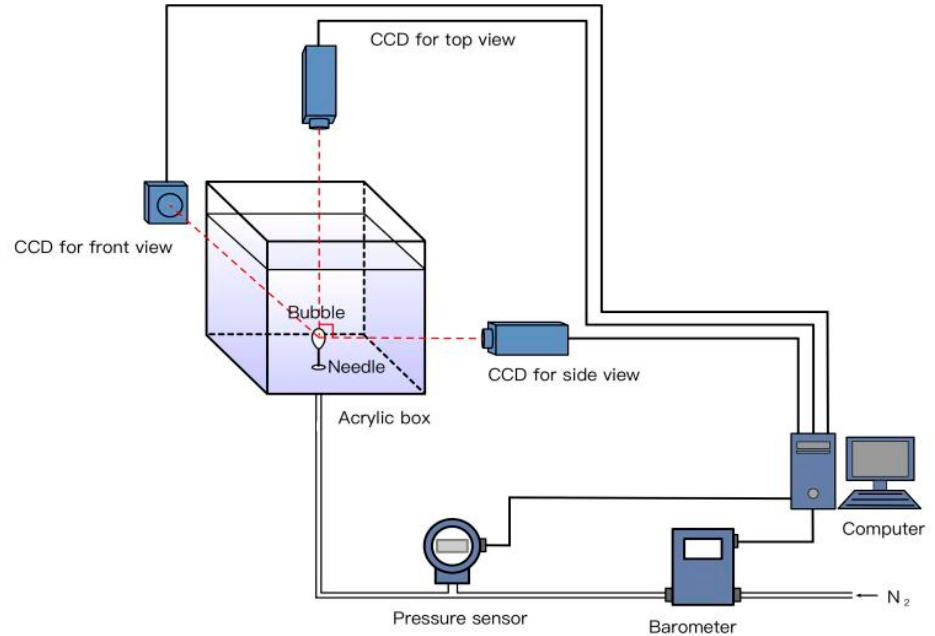
Figure 2. Schematic diagram of the device.